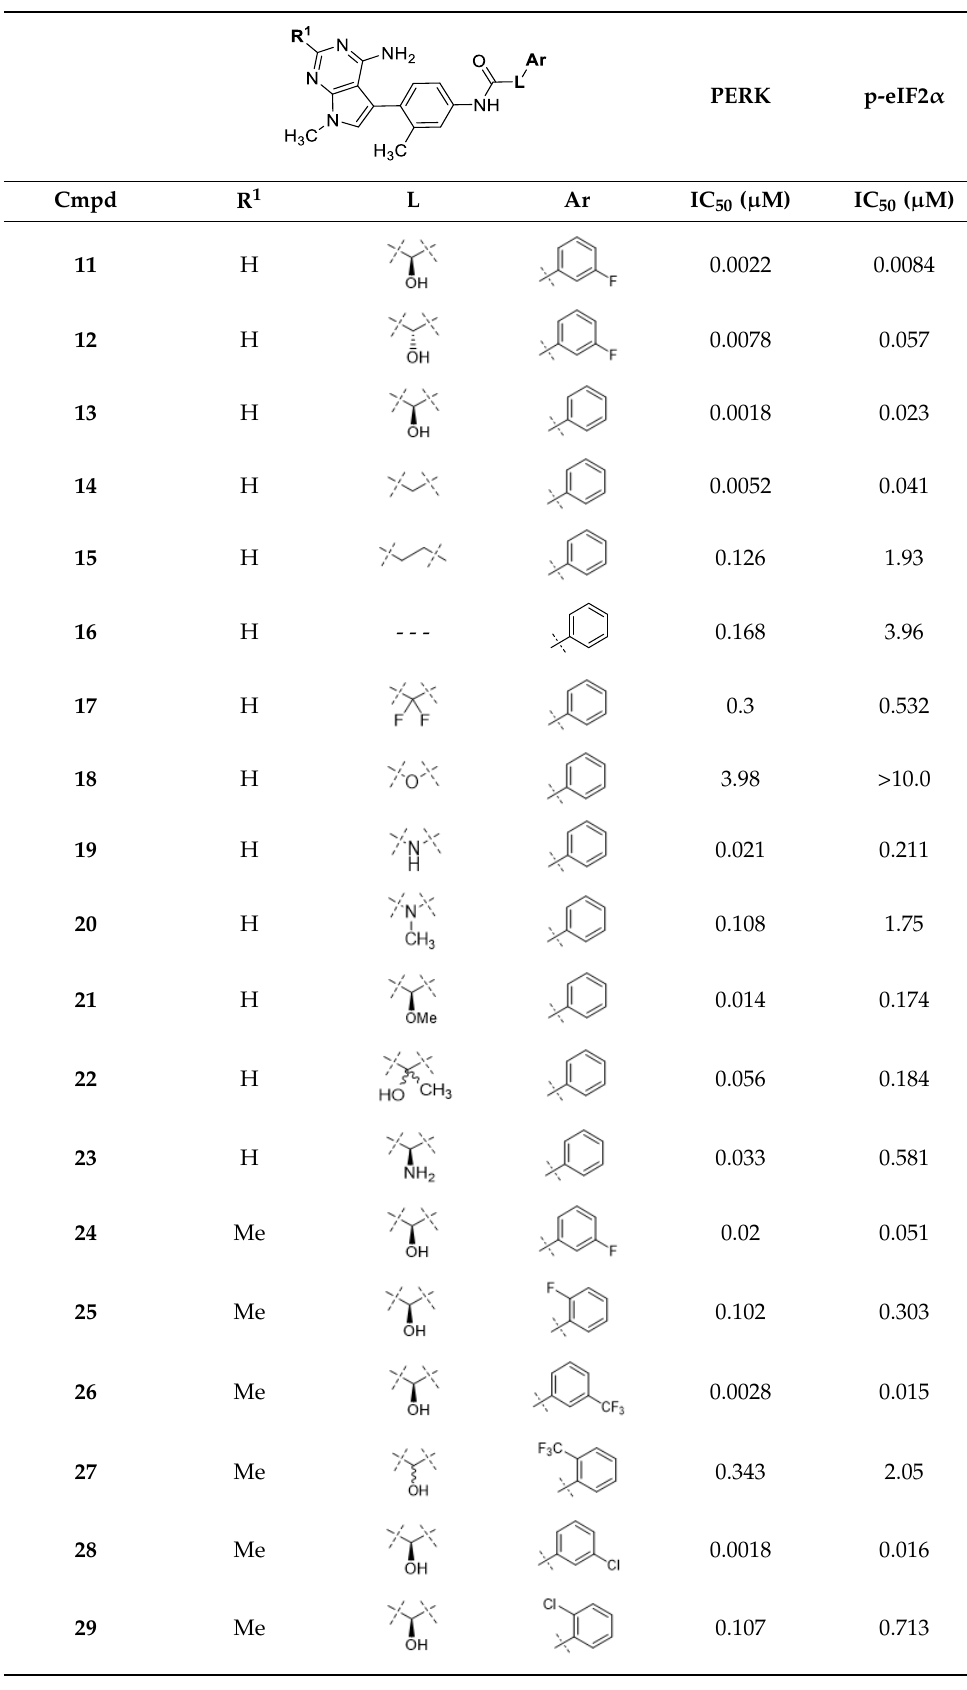
Table 2. In vitro data of PERK inhibitors.